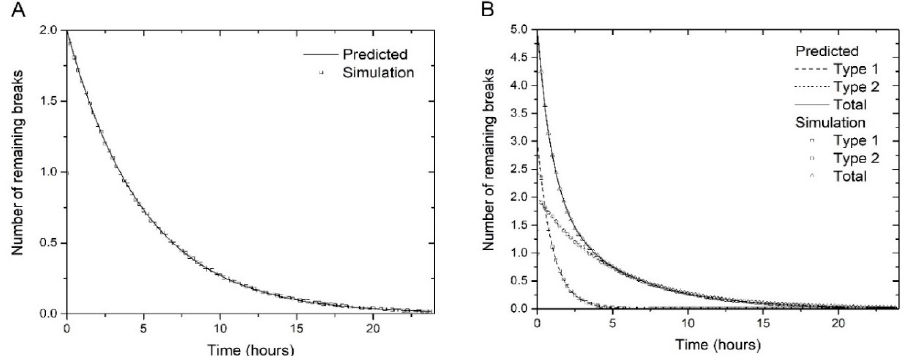
Figure 1. ( A ) Simulation of repair kinetics of breaks using Algorithm 1, with parameters N 1 (0) = 2 , N 2 (0) = 0 and τ 1 = 5 h (i.e. one type of breaks) ( B ) Repair kinetics of type 1 and 2 breaks, and the total number of breaks, as simulated with algorithm 1, with parameters N 1 (0) = 3 , τ 1 = 1 h , N 2 (0) = 2 , τ 2 = 5